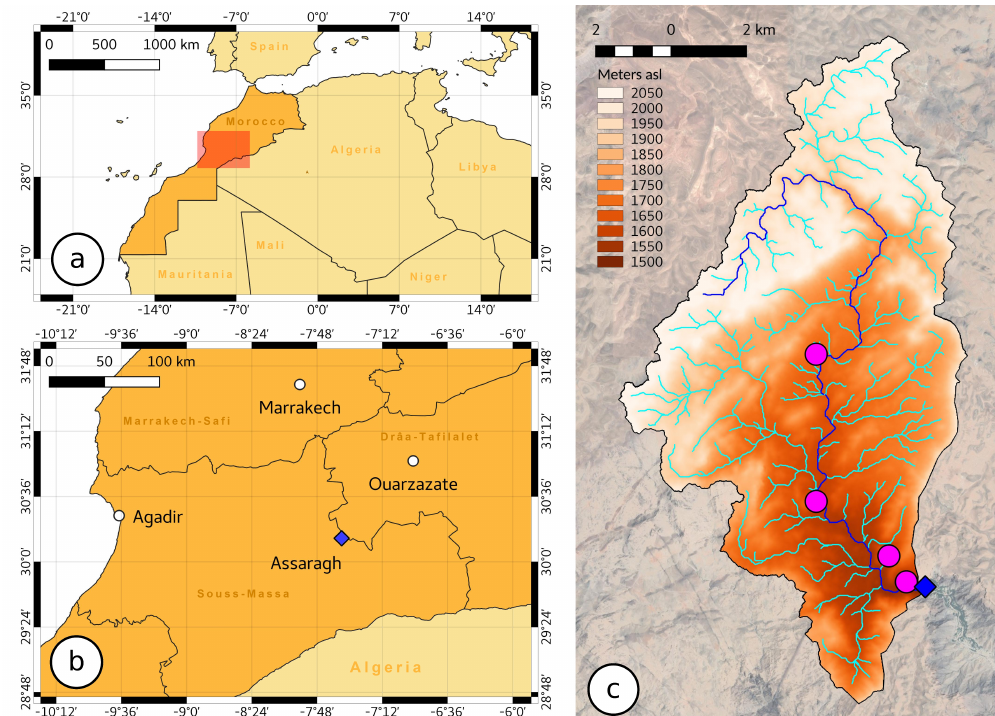
Figure 1. ( a ) Geographical localization of the region. ( b ) Location of Assaragh on the border between the Souss-Massa and Drâa-Tafilalet regions. ( c ) The investigated basin; in deep blue the main wadi stream or assif , in light blue the minor hydrographic network; the deep blue diamond is the closing Section (1506 masl); in magenta, starting from downstream, the four ksours of Assaragh (1560 masl), Lemdint (1620 masl, above the left bank), Iguerda (1620 masl) and Timdghart (1690